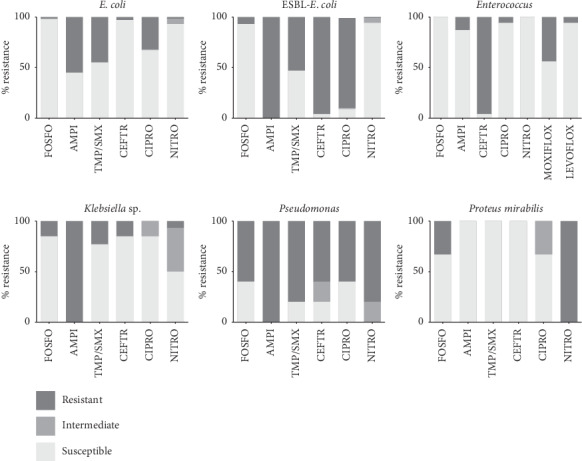
Resistance patterns in isolated uropathogens from community-associated uncomplicated cystitis to optimal treatment options according to IDSA guidelines and the European society for microbiology and infectious diseases.